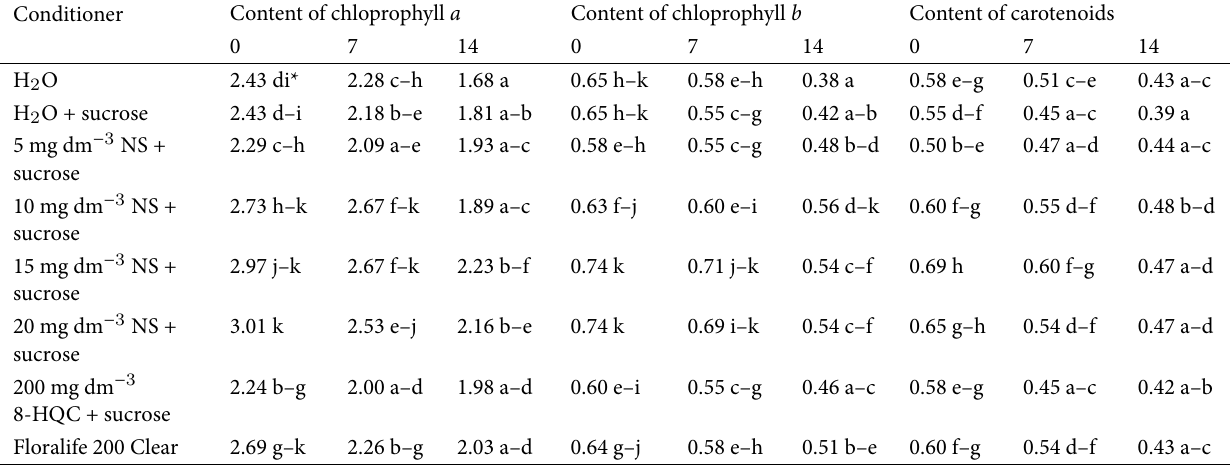
Table 2 Effect of conditioning on chlorophyll a and b and carotenoids content in leaves of Thalictrum aquilegifolium (mg g weight) after 0, 7, and 14 days holding time in water after the 24-hr postharvest treatment. Means from